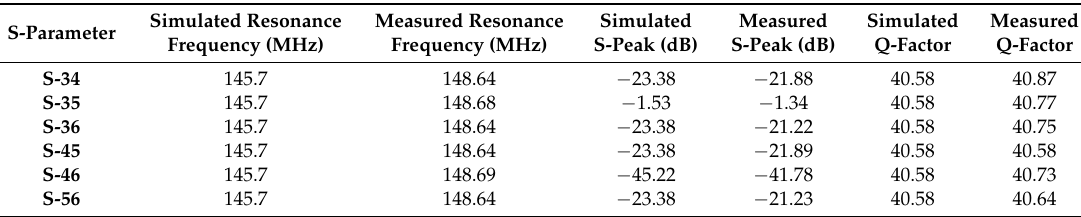
Figure 10. Induced E field ( a ) and H field ( b ) distribution inside the resonator. Maximum induced E is in the same plane as maximum E of the beam. Similarly, maximum induced B (i.e., H) is in the same plane as maximum B of the beam. Table 3. Simulated and measured S-parameters with the resonance frequency and the Q factor for all possible combinations of pickup coupling.